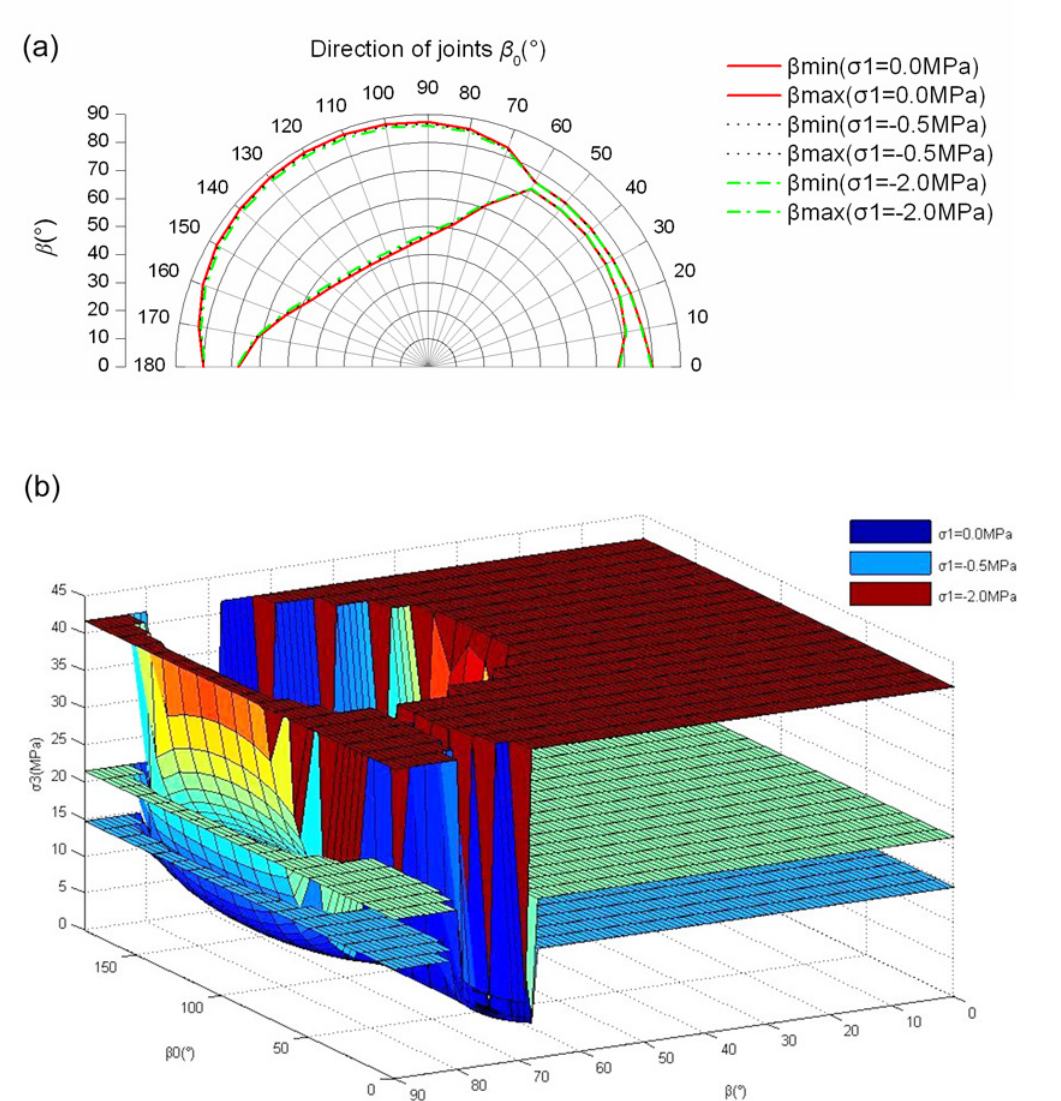
Fig 7. The strength of σ 3 when σ 1 is given((a) The change of β min and β max with different visual angle β 0 ; (b) The change of strength of σ 3 with different